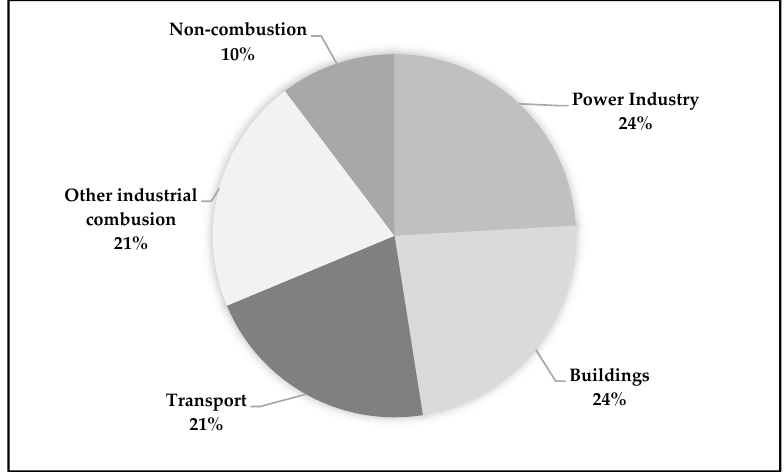
ff erent sectors in Iran, modified from Figure 5. Fossil CO 2 emissions by different sectors in Iran, modified from [76]. Figure 5. Fossil CO 2 emissions by di